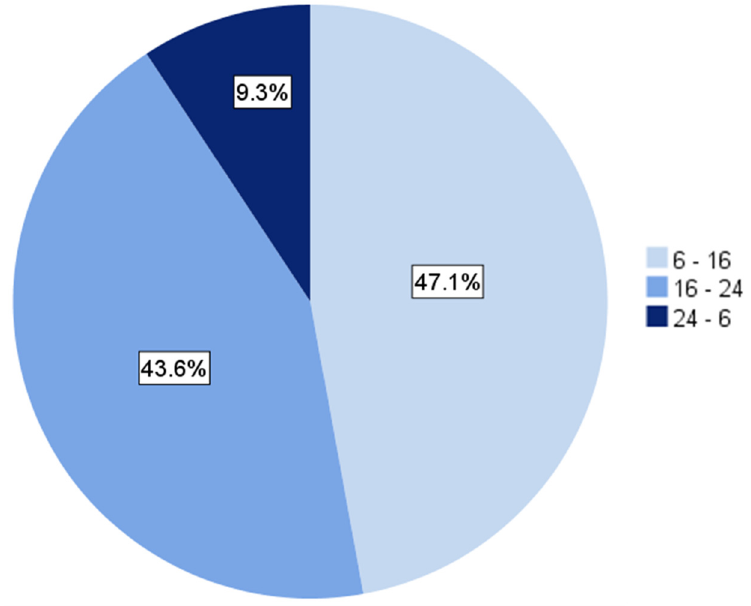
Figure 2. Proportions of patients in the acute MSCC subgroup admitted at different times of day.